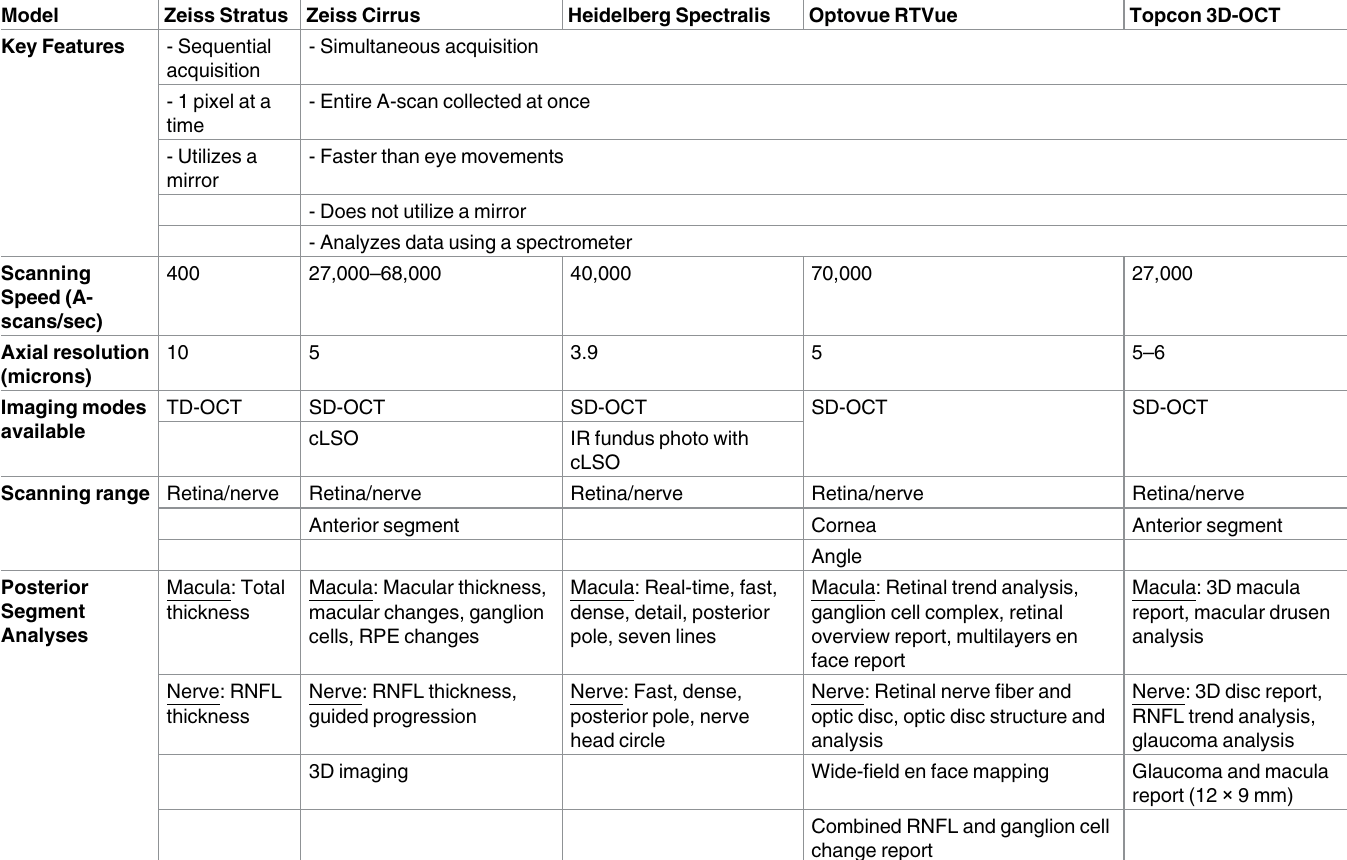
Table 8. Technical featuresof each of the OCT devices studied